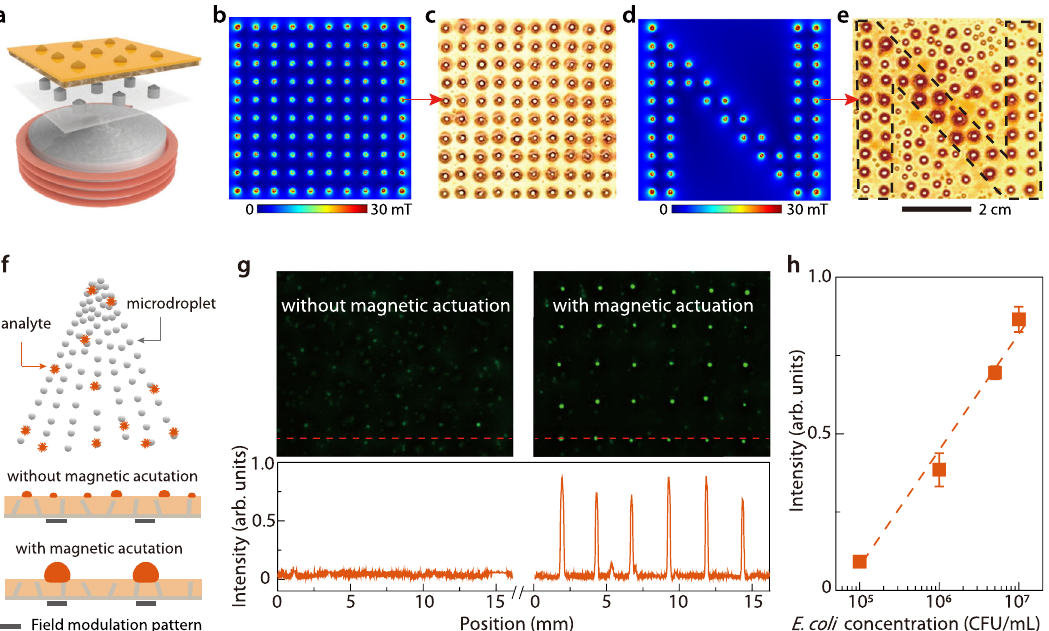
Fig. 4 Collective actuation of microdroplets for droplet collection and biomedical analysis. a A fi eld modulation layer with a lattice pattern was used to guide the microdroplets coalescence. For a square lattice pattern, b the calculated magnetic fl ux density (horizontal projection) on the slippery surface also followed a square lattice pattern. c When micro-sized water droplets were sprayed on the surface, they coalesced and formed a square lattice pattern. d , e For a modulation layer with a N-shape lattice pattern, the calculated magnetic fl ux density (horizontal projection) shown in d and the coalesced microdroplets shown in e also followed a N-shape lattice pattern. Dashed lines in e are eye-guide. f – h This property can be used to collect respiratory droplets and detect the pathogens. f For a proof-of-concept demonstration, microdroplets containing dyed E. coli were sprayed on the surface with a square lattice pattern fi eld modulation layer. g Without magnetic actuation, some microdroplets randomly coalesce, and showed fl uorescence signals that were randomly distributed and were barely above noise level (left image). With magnetic actuation, all the microdroplets coalesce to form a lattice pattern, showing strong and regularly distributed fl uorescence signals (right image). The bottom graph shows the fl uorescence intensity along the dashed oranges lines on the images. h The fl uorescence intensity increases almost linearly with the logarithm of the E. coli concentration, showing potential for quanti fi cation. Error bars represent the standard deviation ( n =